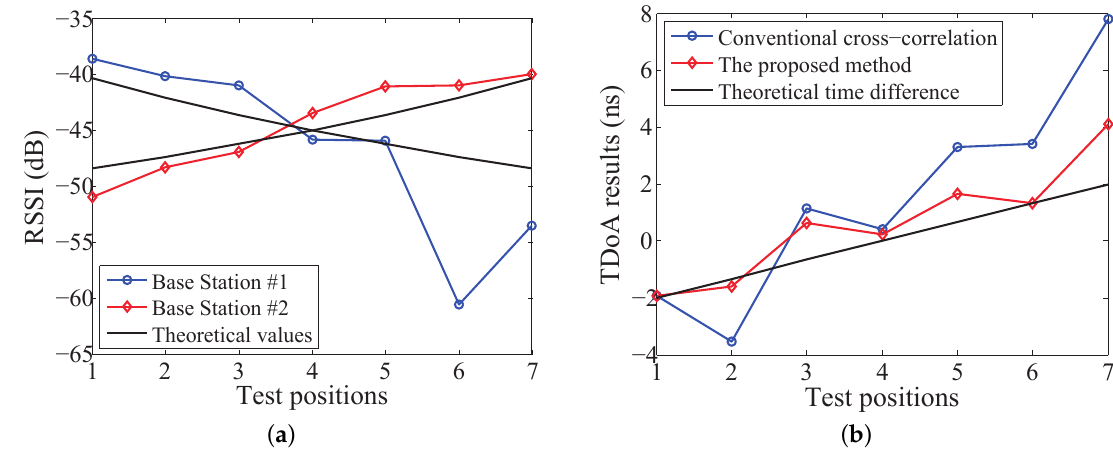
Figure 13. 1D position sensing experimental results at 7 test positions: ( a ) RSSI values of base station #1 and #2; ( b ) TDoA calculation results of the conventional cross-correlation method and the proposed